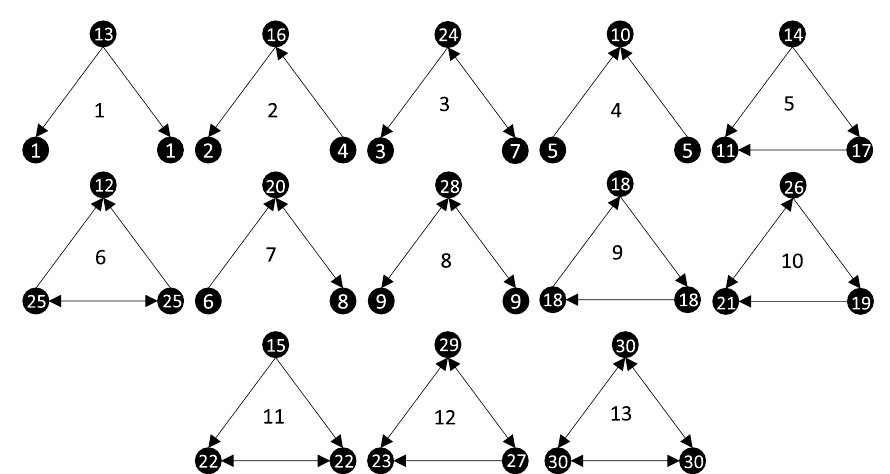
Fig. 1 13 motifs and 30 roles for directed 3-node